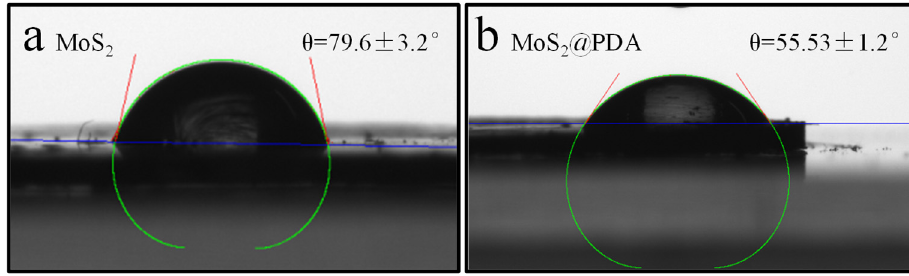
Figure 3. Water contact angles of MoS 2 ( a ) and MoS 2 @PDA ( b ).